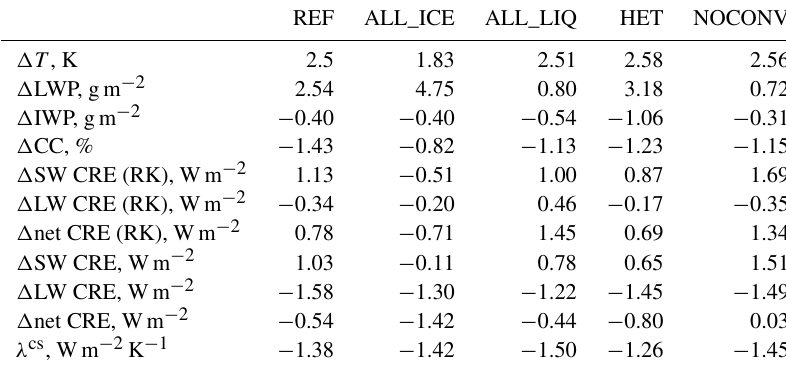
Table 3. Global annual mean changes of surface temperature ( (cid:49)T s ), liquid water path ( (cid:49) LWP), ice water path ( (cid:49) IWP), vertically integrated cloud droplet ( (cid:49)N l ) and ice crystal number concentration ( (cid:49)N i ), total cloud cover ( (cid:49) CC), SW CRE ( (cid:49) SW CRE), LW CRE ( (cid:49) LW CRE), and net CRE from the radiative kernel (RK) method and as normally diagnosed in equilibrium after a CO 2 doubling averaged over the years 26 to 50 of the coupled atmosphere – MLO model simulations as well as the net clear-sky feedback parameter λ cs diagnosed according to Block and Mauritsen (2013). The individual simulations are described in Table 1. Different from Table 2, here the changes in LWP are global and not limited to ocean